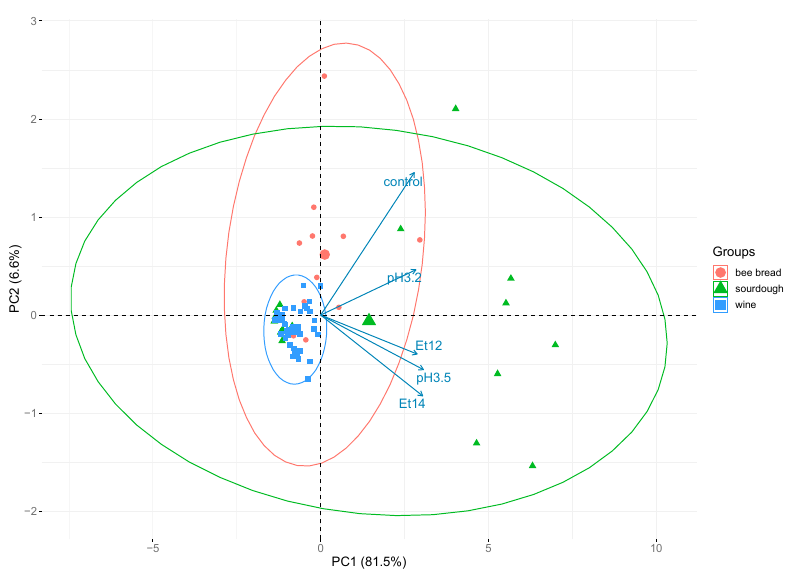
Figure 2. Principal component analysis (PCA) biplot of the first two principal components grouped (groups) by matrix of isolation.